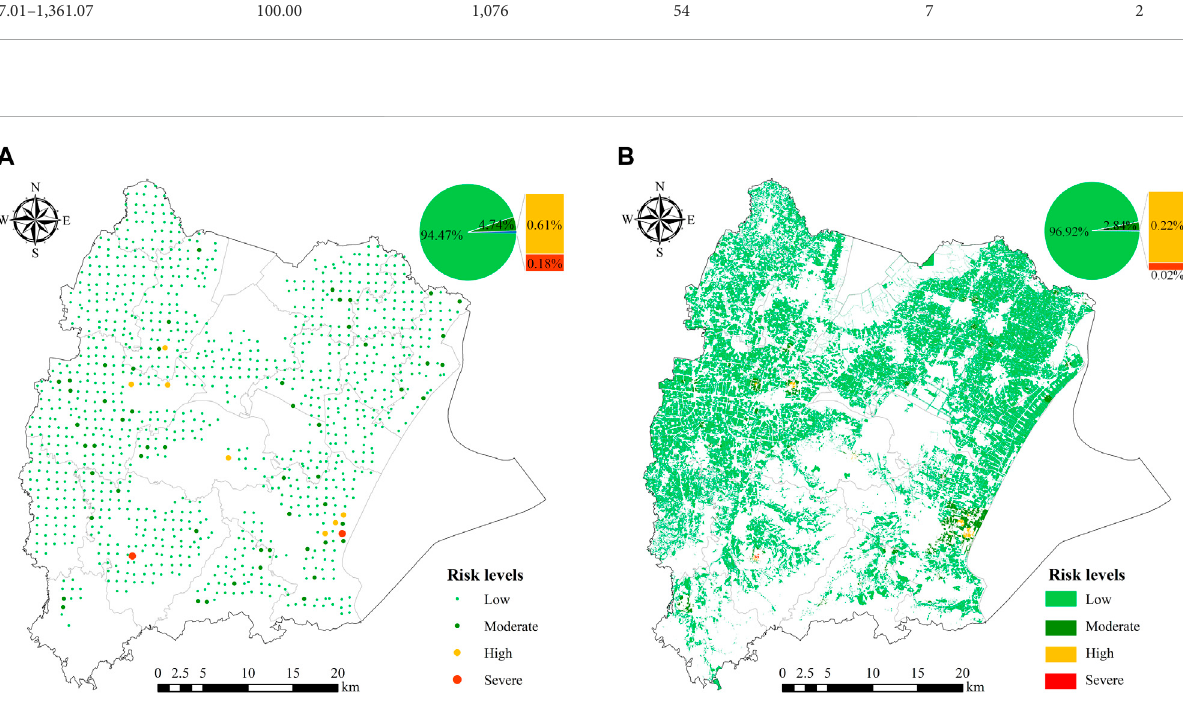
TABLE 5 Evaluation results of the potential ecological risk index ( RI -values) for heavy metals in soil. Range Mean The proportion of sample sites with different risk levels (number of samples) Low Moderate High Severe